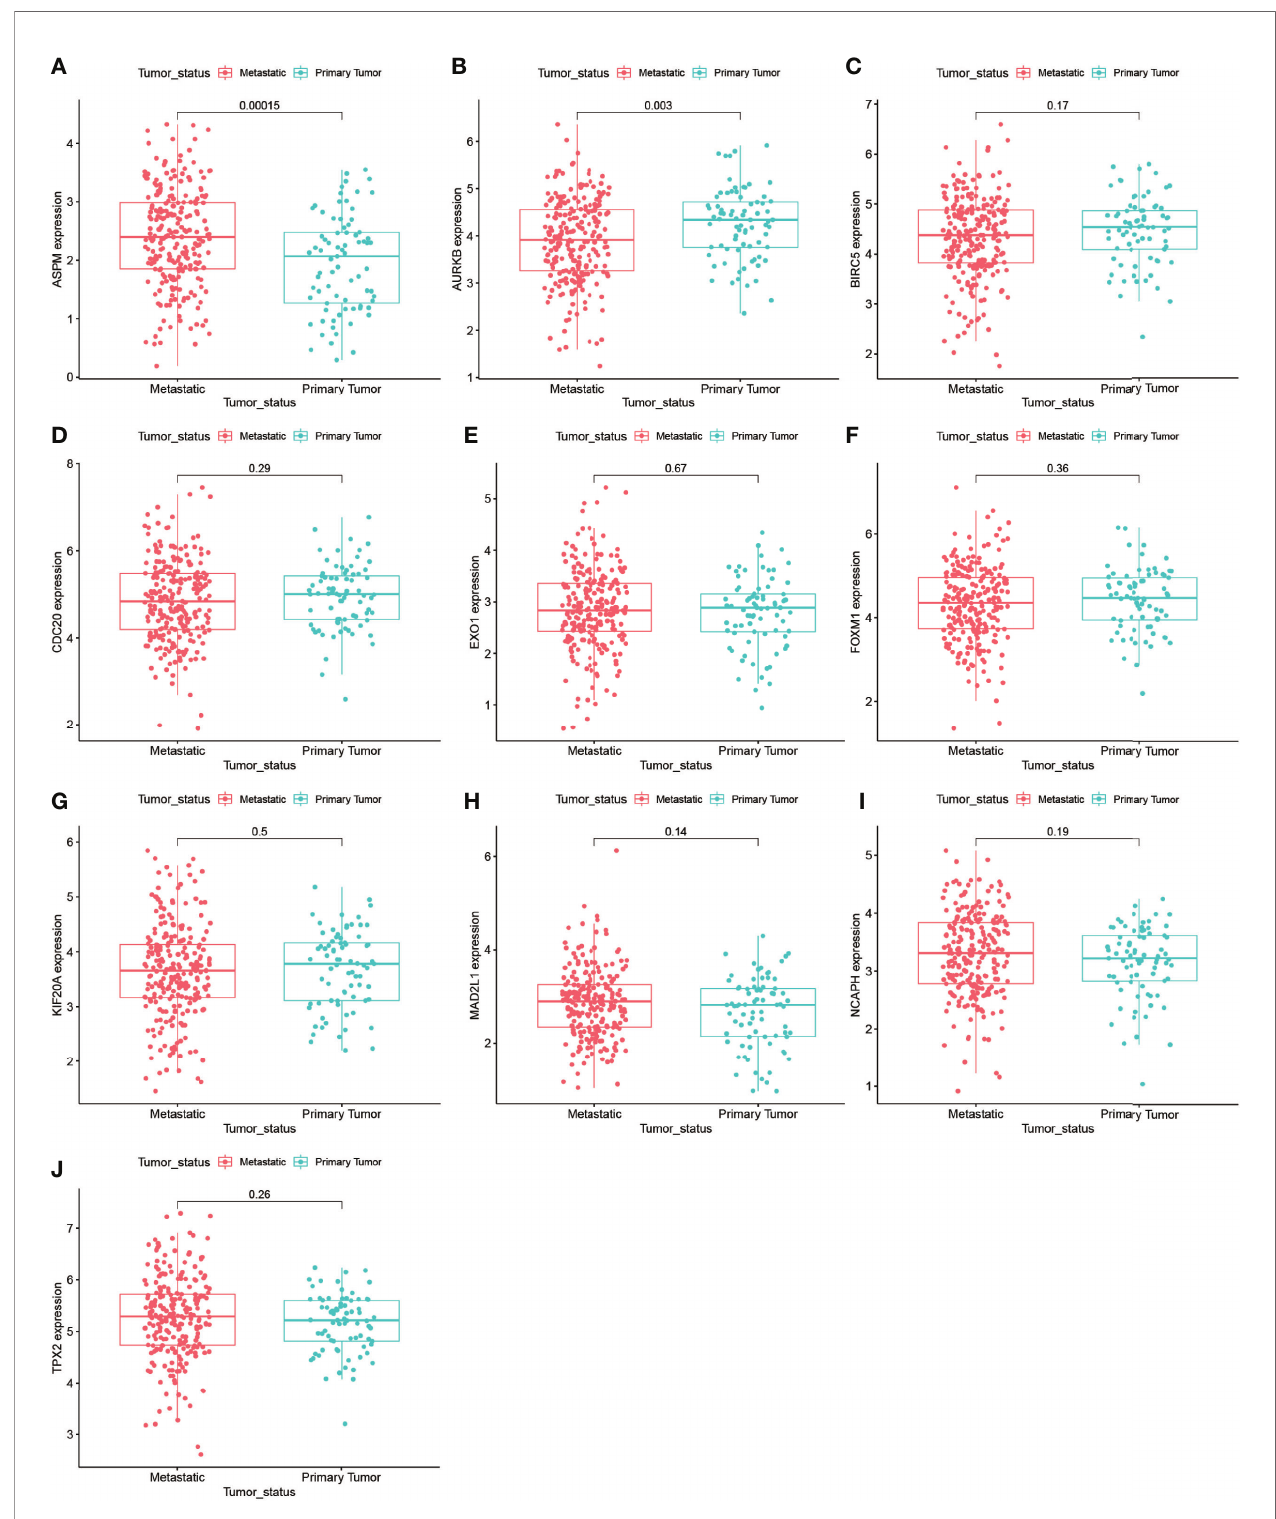
FIGURE 10 | Gene expression of the top 10 Hub genes in the metastasis and primary tumor groups. (A – J) demonstrate the differences in gene expression of the top 10 Hub genes in the metastasis-bearing group and in the primary tumor